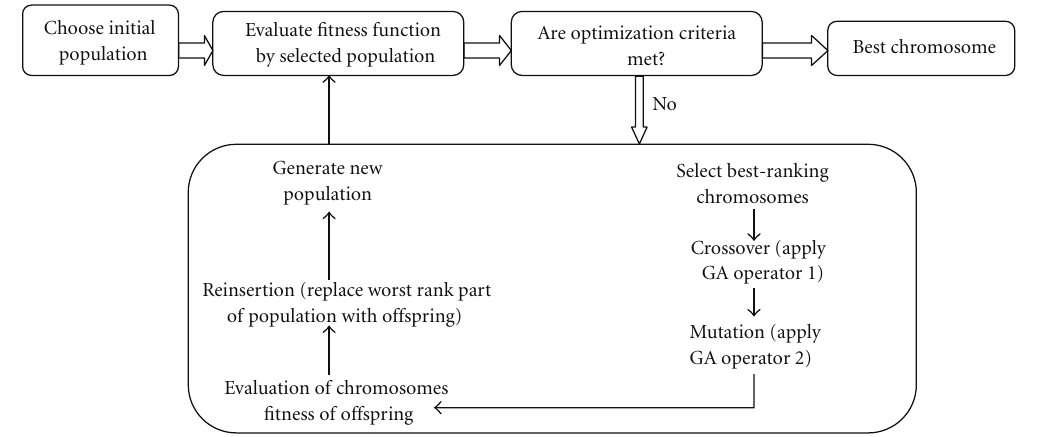
Figure 2: Flowchart of a GA